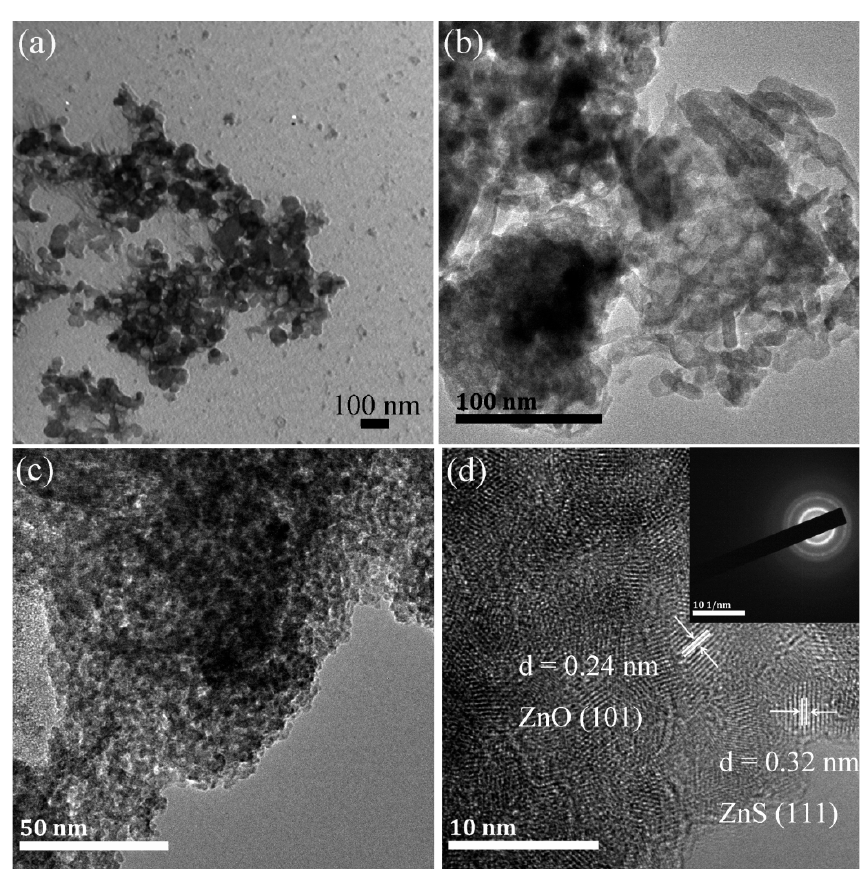
Figure 2. TEM images of ZnS ( a ), ZnO ( b ), and ZnO/ZnS photocatalyst ZOS-0.9 ( c ); HRTEM image ( d ), and SAED patterns (inset of d) of